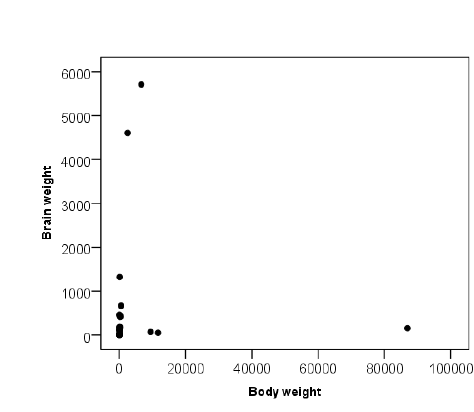
Correlation between body weight and brain weight (raw)